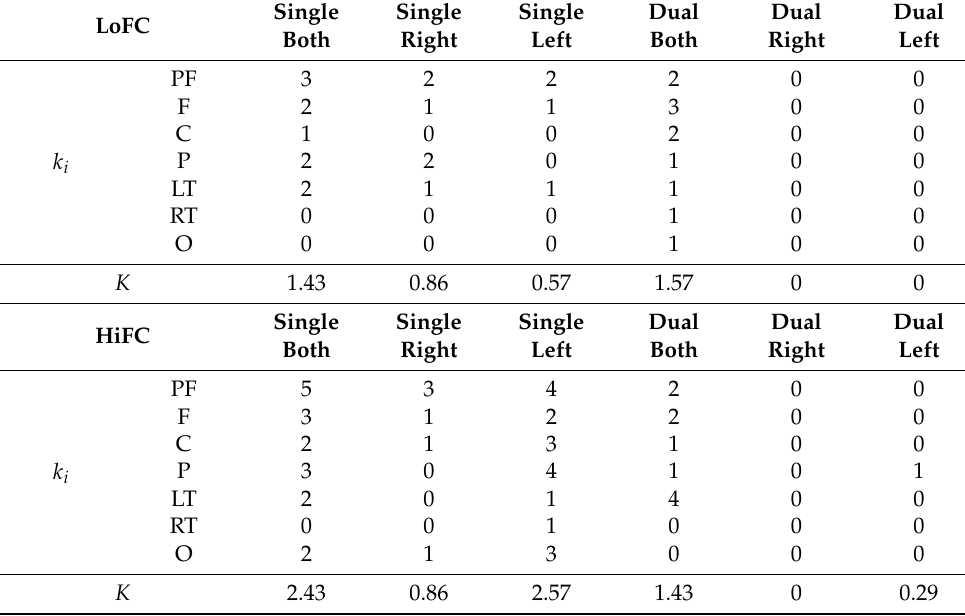
The seven brain regions are the prefrontal (PF), frontal (F), central (C), parietal (P), left-temporal (LT), right- temporal (RT), and occipital (O) areas. k i and K are calculated by (2) and (3),